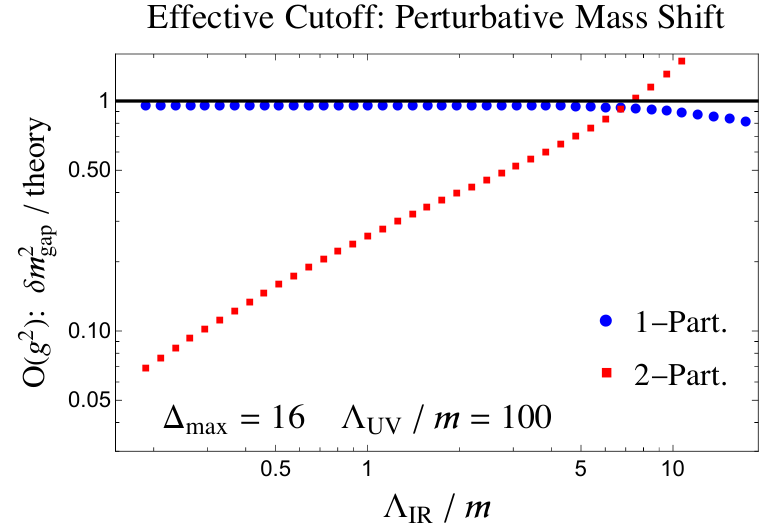
Figure 17 . The O ( g 2 ) correction to the one-particle state (blue) and lowest two-particle state (red), normalized by the theoretical prediction set by Λ ∆ = 16 , Λ = 100 , and r = 0 . 8 . The two-particle shift continually decreases as Λ max UV /m decreases, indicating that it sees a separate cutoff than Λ